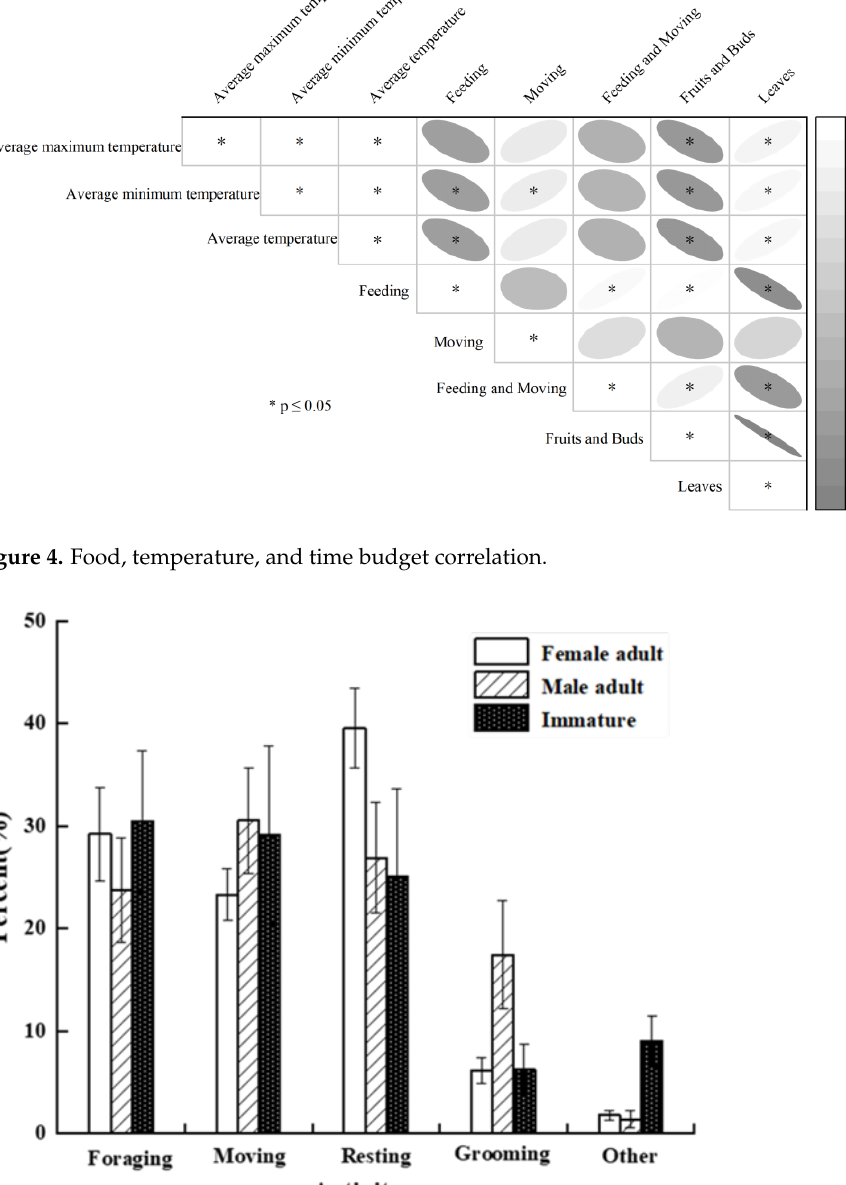
Figure 5. Comparison of time budgets between different sex-age groups.